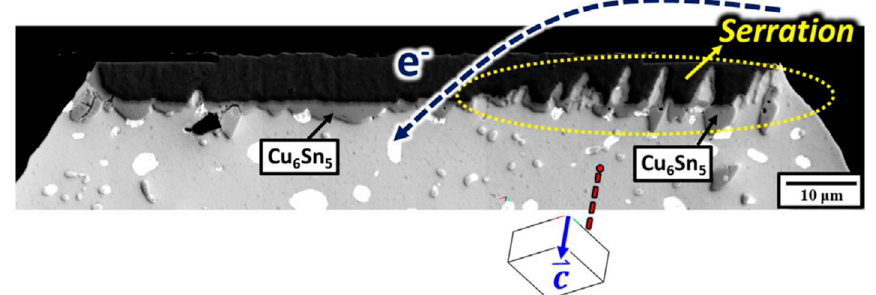
Figure 8. Serrated cathode dissolution occurred at the chip side of the joint after a current stressing of 3.5 × 10 4 A/cm 2 at 50 × C for 1500 h Reprinted with permission from Ref. [41] Copyright 2015 Elsevier.